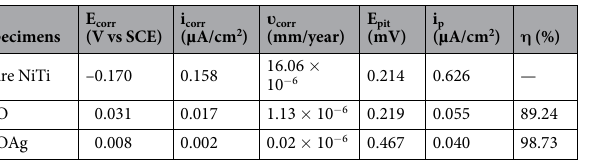
Table 3. Corrosion parameters of the bare NiTi alloy, GO-coated NiTi (GO), and GO/Ag-coated NiTi (GOAg)